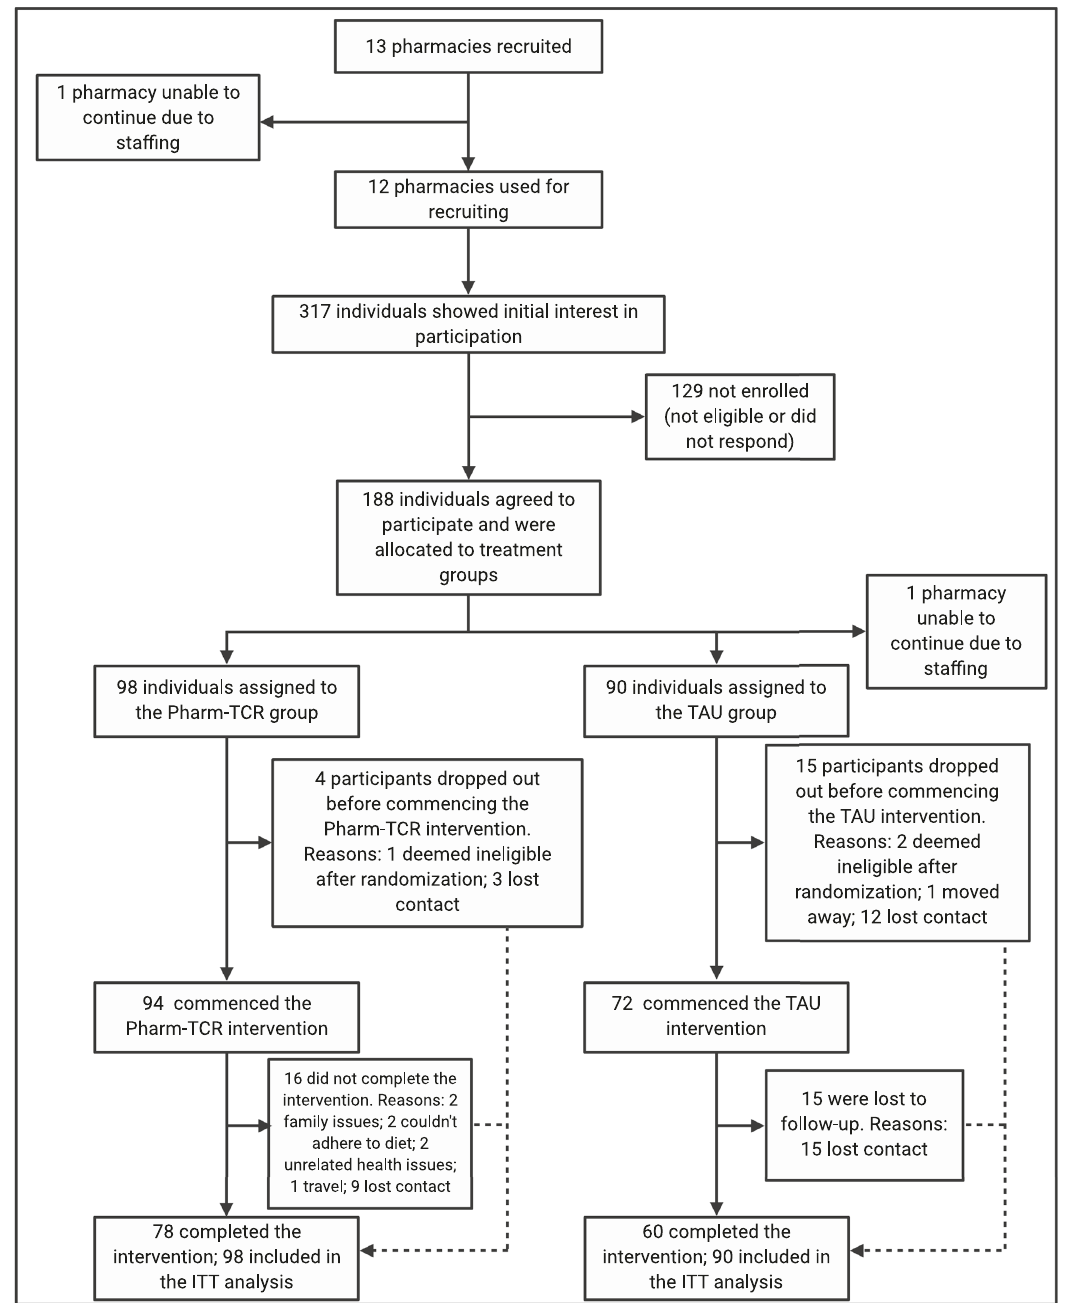
Fig. 1 Trial CONSORT fl ow diagram. Pharm-TCR Pharmacist-led therapeutic carbohydrate restriction, TAU Treatment-as-usual, ITT Intention-to-treat. Created with